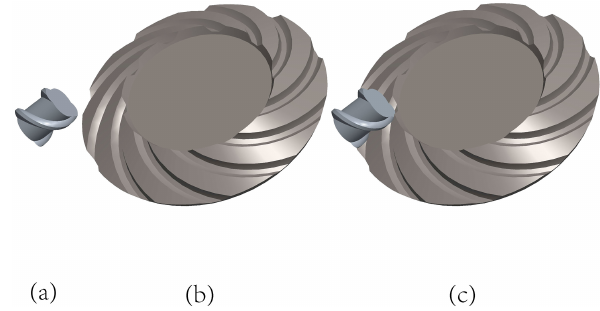
Figure 8. 3-D solid model 1. (a) Driving gear 1; (b) driven gear 1; (c) meshing simulation.